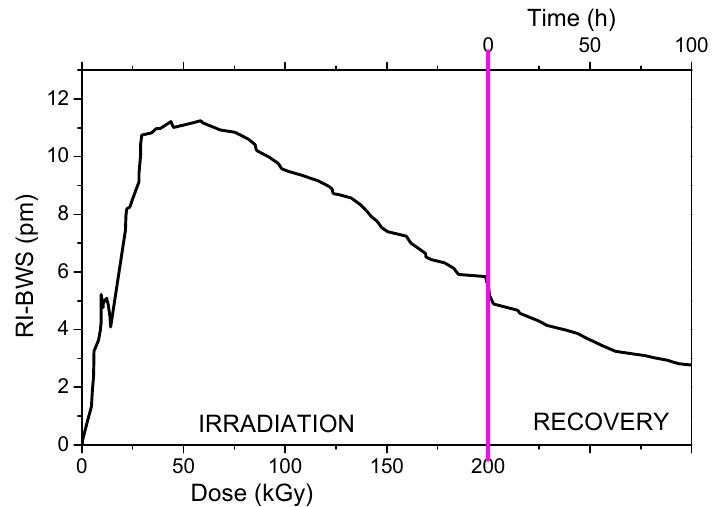
Figure 11. γ -rays-induced Bragg wavelength shift on type I FBGs, inscribed with an ns-pulsed UV laser (at 248 nm, a pulse width of 15 ns, and pulse energy of 8 mJ) in an unloaded highly Ge-doped core (~8 mol% of GeO 2 ). The vertical pink line indicates the irradiation end. The accumulated dose reached in the only first irradiation run, here reported, was around 200 kGy, the dose rate being of about 0.28 Gy/s and a temperature of about 34 °C. Data extracted from [92].